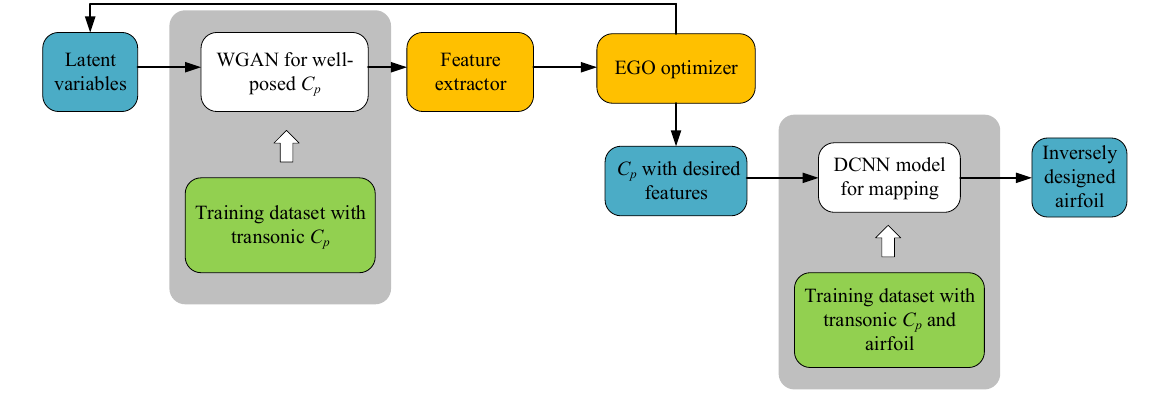
Figure 1. Flowchart of the proposed method.